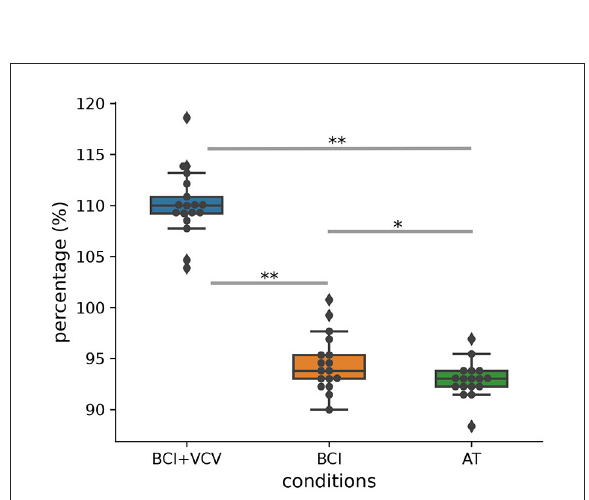
FIGURE5 Robot performance relative to the training session. The horizontal line in a box shows the performance median. The upper and lower lines of a box represent the upper and lower quartiles, respectively. The whiskers extend to points that lie within 1.5 interquartile ranges of the lower and upper quartile. ∗ p < 0.05, ∗∗ p < 0.001.